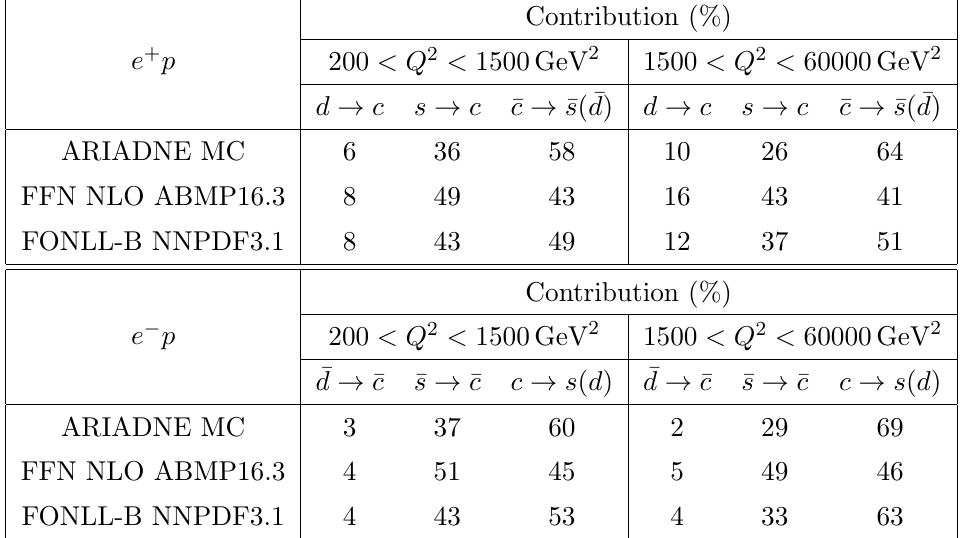
Table 3. Contribution (%) of charm subprocesses to EW charm production in CC DIS in both e + p and e (cid:0) p collisions, as predicted by the ARIADNE MC and FFN and FONLL-B schemes. The labels are explained in table 1. Additionally for the MC and FONLL-B scheme, the contribution of the QPM process in (cid:12)gure 1 (ii) enters in the third column ((cid:22) c ! (cid:22) s ( (cid:22) d )) with a higher-order correction from the BGF process in (cid:12)gure 1 (iv). For the FFN scheme, the process described in (cid:12)gure 1 (ii) does not participate. Thus the content of the third column is provided by the BGF process of (cid:12)gure 1 (iv) only.